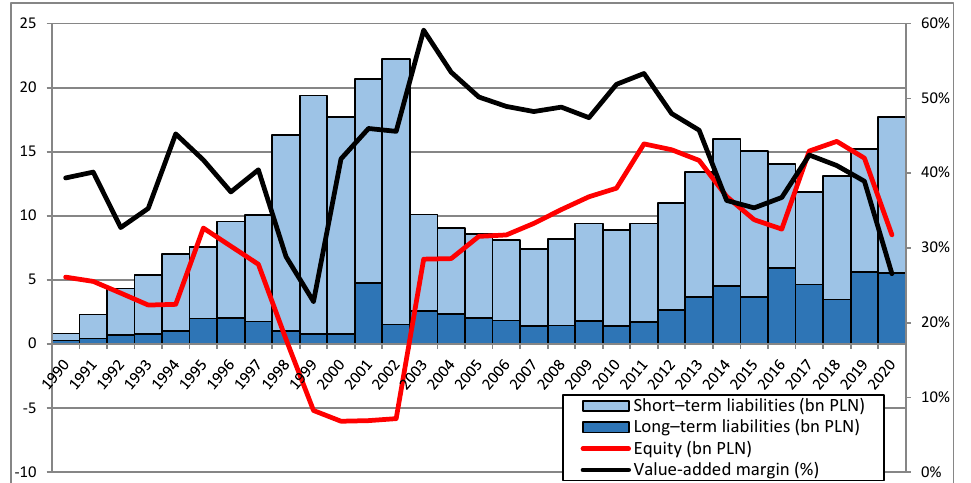
Figure 3. Short and long-term liabilities, equity and value-added margin of coal mining enterprises in 1990 – 2020. Note: value-added margin — right axis. Source: as in Figure 1.